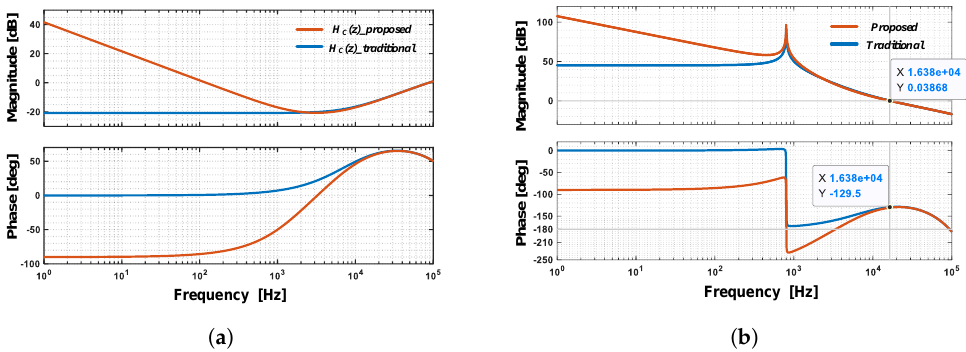
Figure 5. TA frequency response comparison with different type of compensator: ( a ) the frequency response of loop compensator H C ( z ) ; ( b ) the frequency response of total loop gain LG ( z )